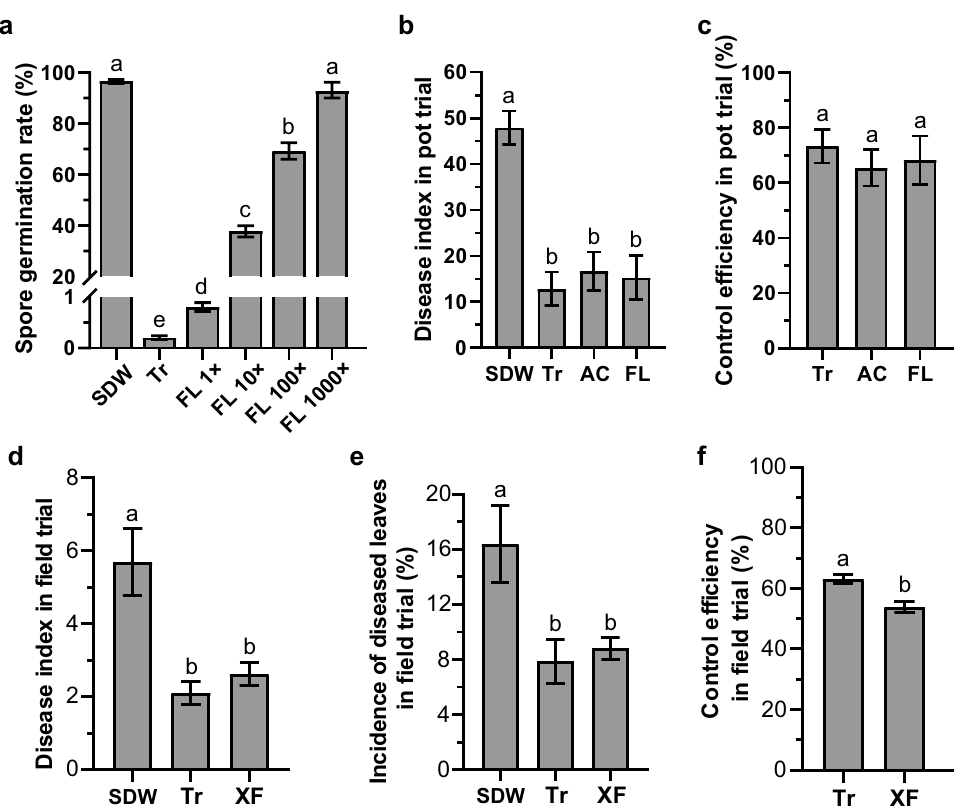
Fig. 1 The control effect of Streptomyces tauricus XF on wheat stripe rust. a The germination rate of urediniospores treated with various dilutions of fermentation liquid. SDW, sterile distilled water; Tr, triadimefon was 20 μg/mL; FL, XF fermentation filtrate; ‘ The disease index in a pot trial. Tr, 20% triadimefon emulsions at a concentration of 0.5 g/L. c Control efficiency of XF against wheat stripe rust in a pot trial. The three values were not significantly different from each other. d The disease index of wheat stripe rust in the field trial. e Wheat leaves disease incidence in the field trial. f The control efficiency in the field trial. SDW, sterile distilled water; AC, XF actinomycete cell suspension (10 7 CFU/ mL); FL, XF fermentation filtrate; XF, XF fermentation broth containing AC and FL. Values in charts are mean tests, different lowercase letters indicate differences with significance level